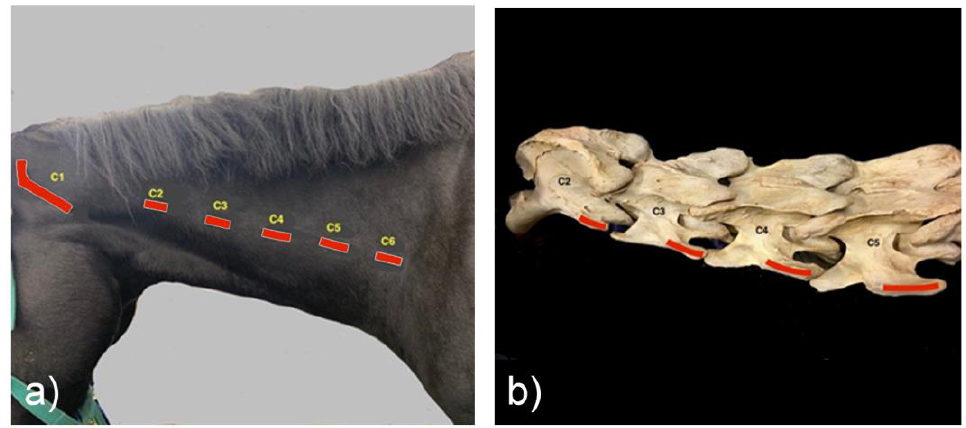
Figure 1. ( a ) Lateral neck with palpable landmarks of the caudal transverse processes marked in relation to the cervical vertebrae (C1–C6). ( b ) Equine cervical vertebrae C2 to C5, with red lines indicating palpable landmarks.